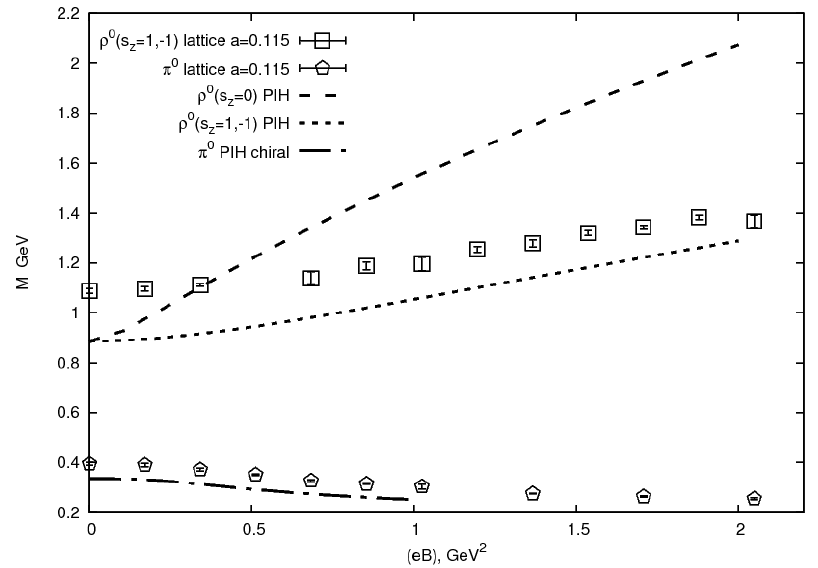
Figure 6 . Mass evolution of ( (cid:25) 0 ; (cid:26) 0 )( d (cid:22) d ) quartet in MF from our analytic (PIH) and lattice data with a = 0 : 115 ; fm .